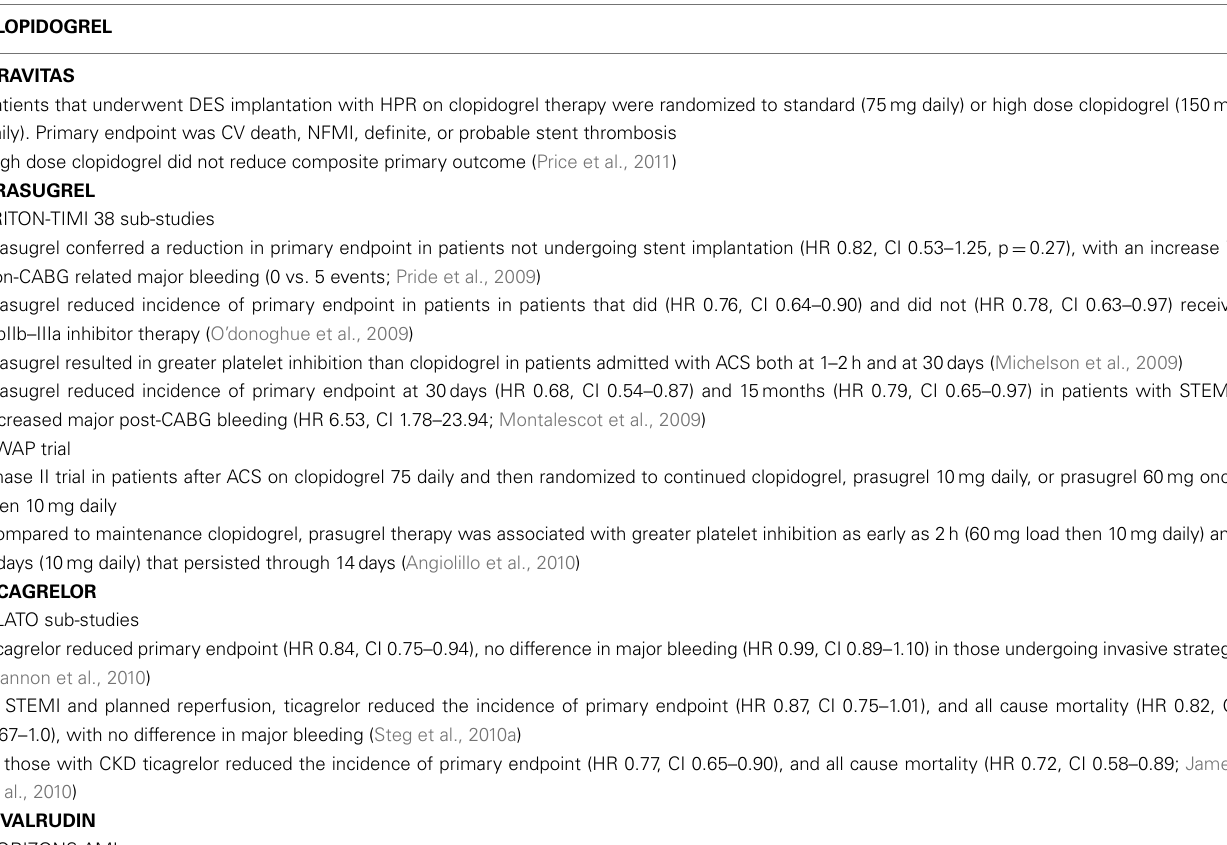
Table 4 | Recent trials ofACS